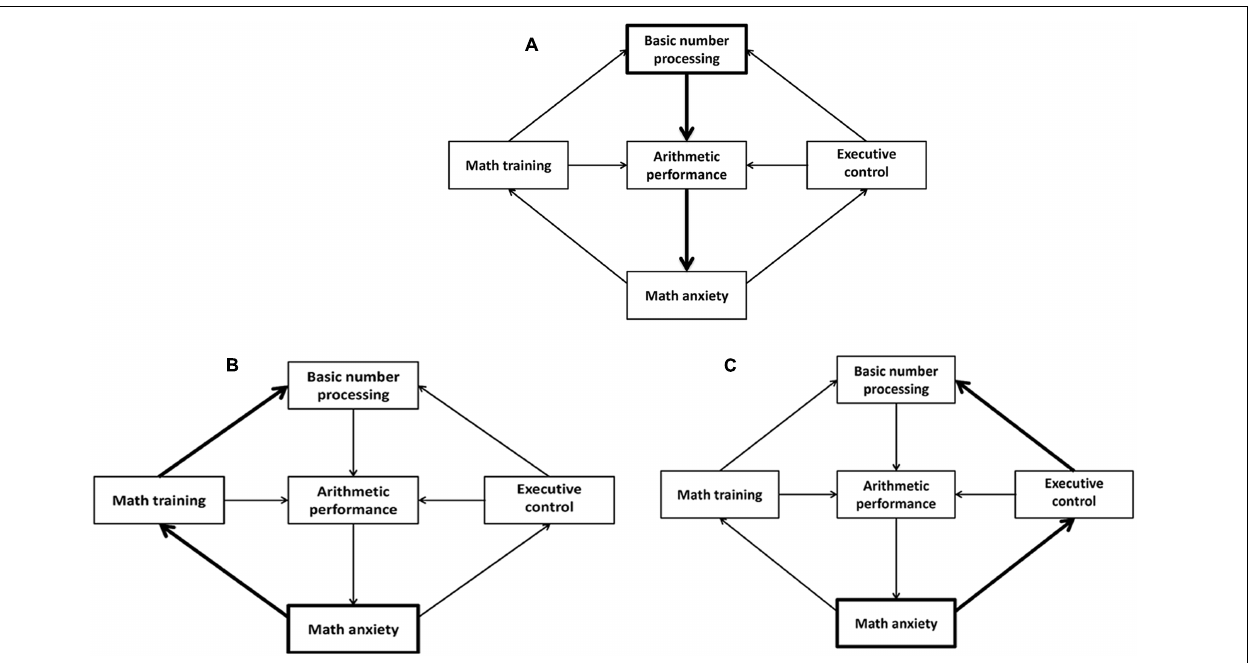
FIGURE 3 | Schematic representations of the different mechanisms potentially accounting for the relationship between math anxiety and basic numerical processing (SNARC effect). Deficits in basic numerical processing lead to math anxiety via weaker arithmetic performance (A) . Math anxiety leads to deficits in basic numerical processing via insufficient math training (B) or weaker executive control (C) . The origin and pathways for each of the different mechanisms are highlighted in